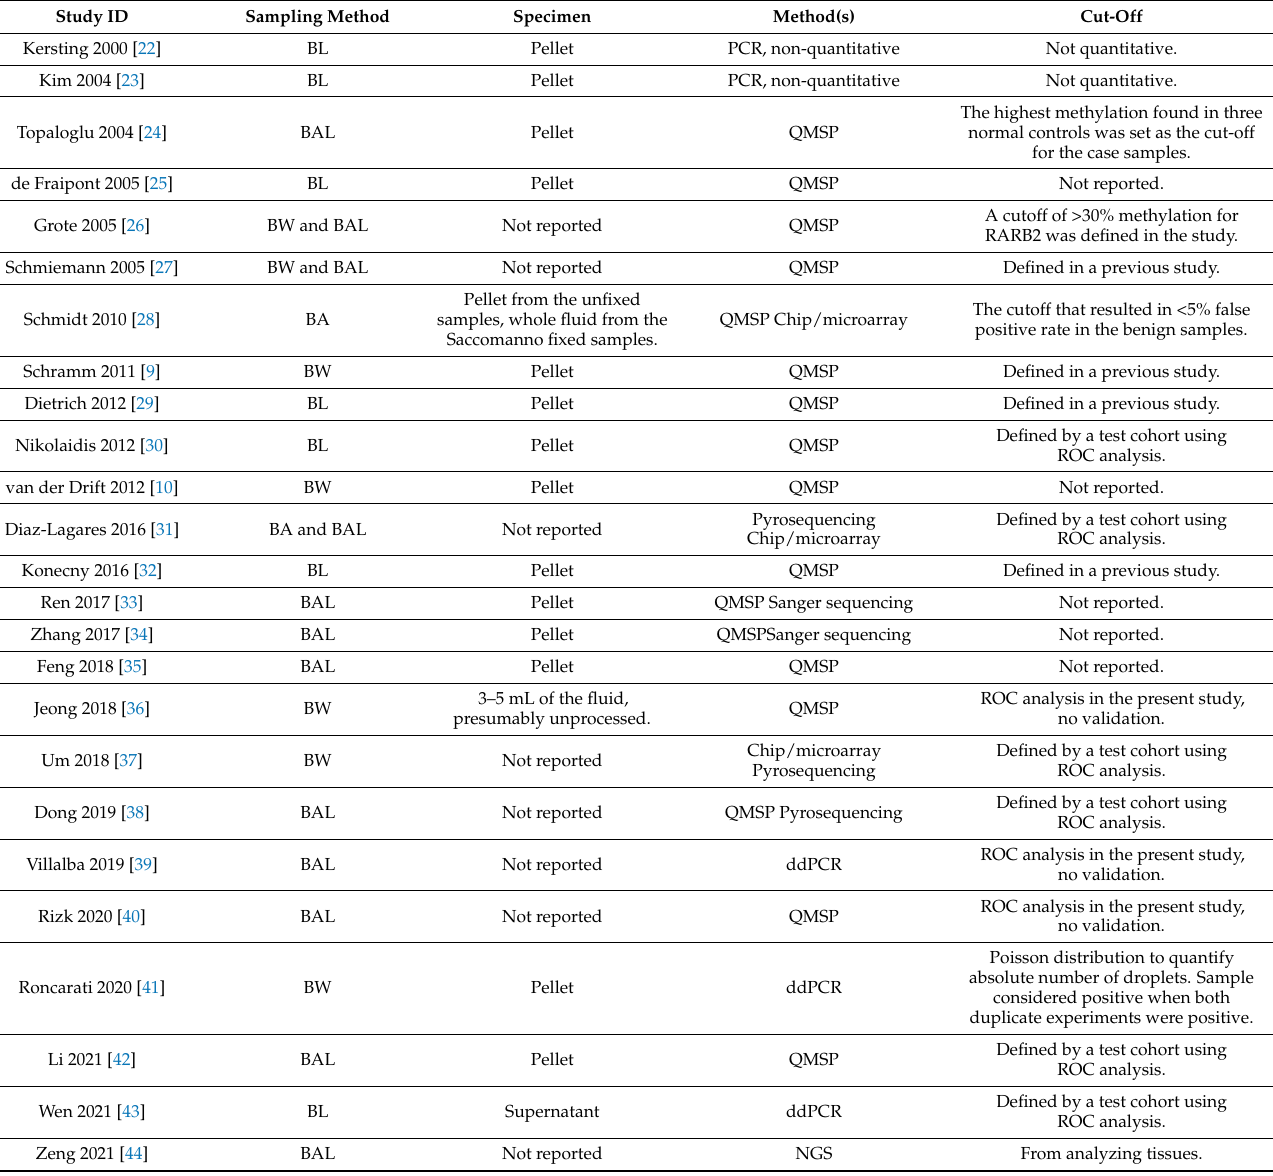
Table 2. Sampling methods: Bronchial lavage (BL), bronchoalveolar lavage (BAL), bronchial wash (BW), and bronchial aspirates (BA). Specimen used: Cell pellet, supernatant, or unprocessed or fixed fluid samples. Analysis methods: Non-quantitative polymerase chain reaction (PCR),